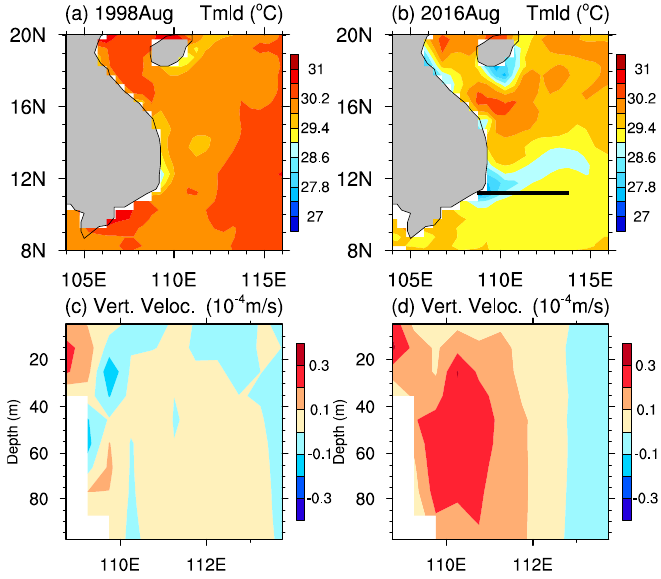
Figure 4. Spatial distribution of mixed-layer temperature (shading, units: ◦ C) during August in ( a ) 1998